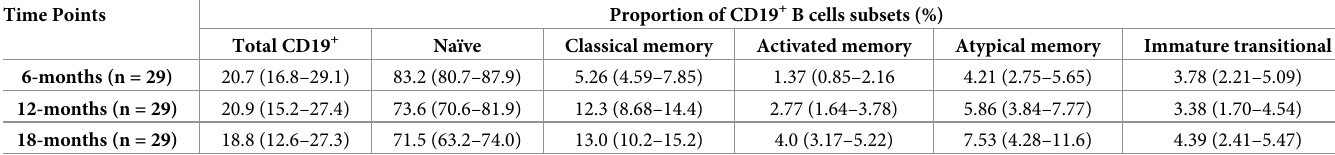
Table 3. Median proportion of B cell subsets in the study participants at different age points (6, 12 and 18 months). Time